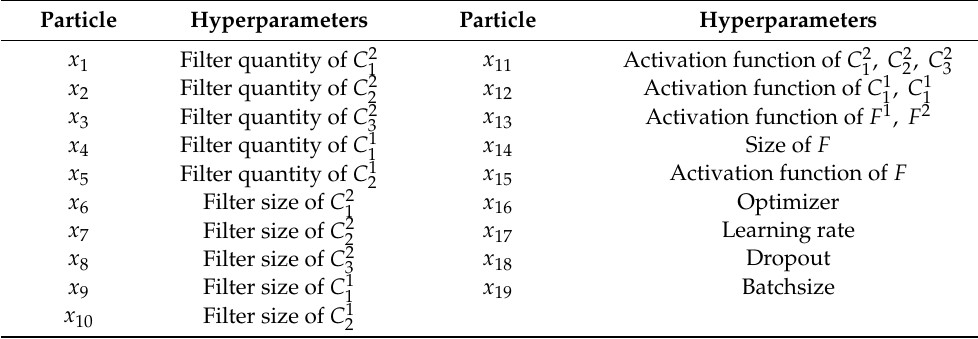
Table 1. Hyperparameters of